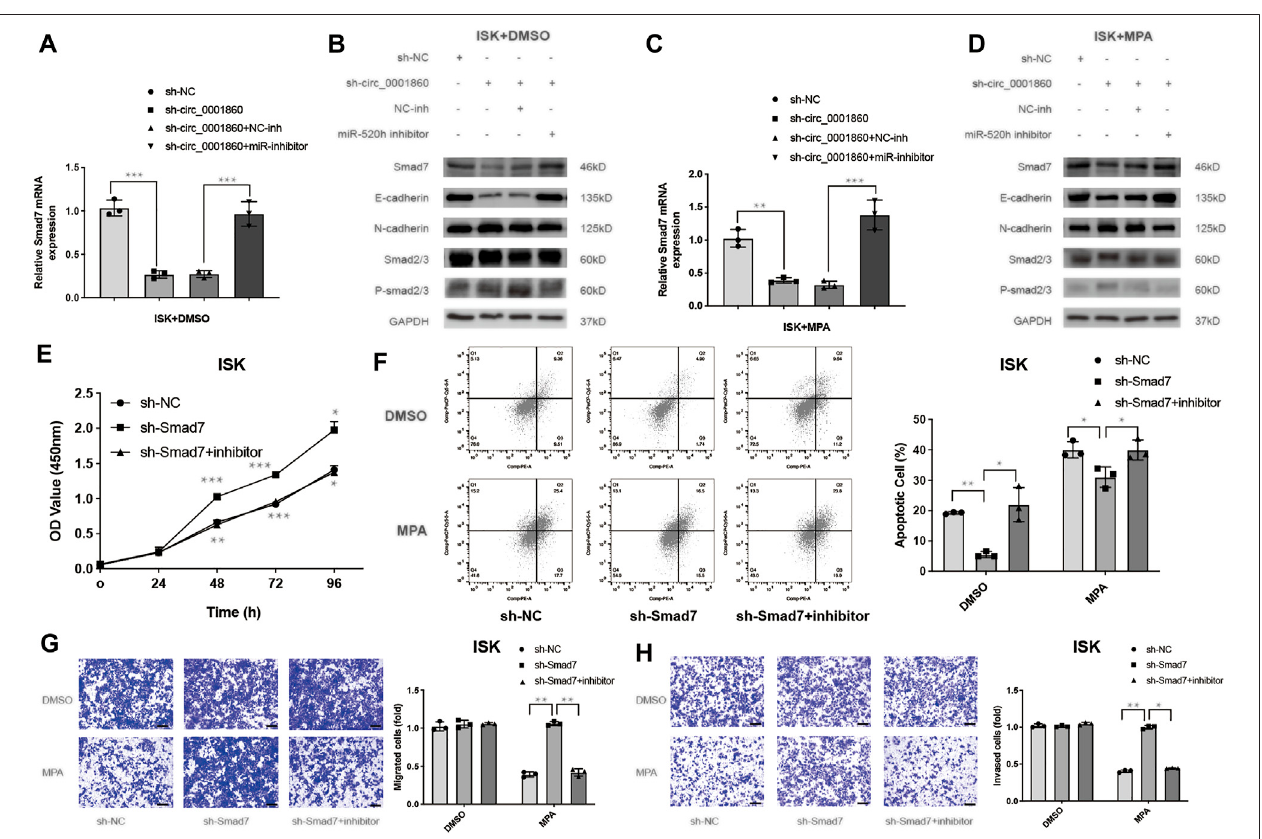
FIGURE 6 | Hsa_circ_0001860 regulates Smad7 expression and activates the Smad7/epithelial-to-mesenchymal transition (EMT) signaling pathway. (A, C) The expression levels of Smad7 were analyzed using RT-qPCR. ISK cells were transfected with indicated vectors alone or co-transfected with inhibitors treated with DMSO (control)orMPA(10 μ M). (B,D) Theexpression levelsofSmad7, Smad7/EMTsignalingmoleculessuch asphosphorylatedSmad2/3,E-cadherin, and N-cadherin were determined using Western blotting in ISK cells transfected with the indicated vectors alone or co-transfected with inhibitors treated with DMSO (control) or MPA (10 μ M). (E) Cell proliferation, (F) apoptosis, (G) migration, and (H) invasion of ISK cells after transfection with sh-Smad7 combined with miR-520 h inhibitors or NC inhibitor (magni fi cation, × 100; scale bars (cid:2) 100 μ m). * p < 0.05, ** p < 0.01, *** p <